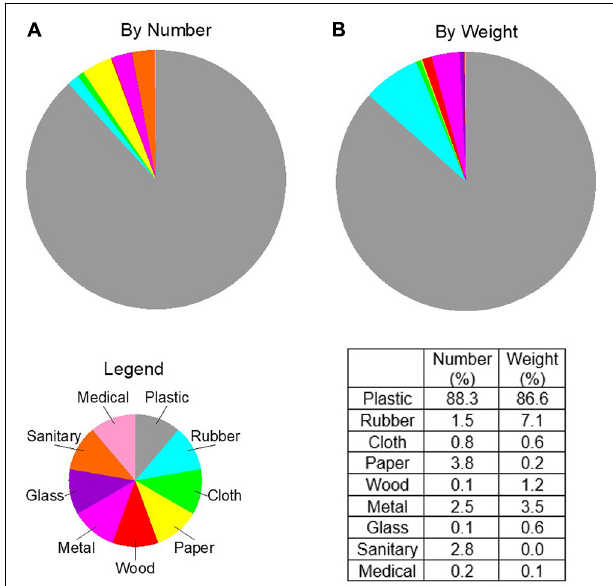
FIGURE 2 | Composition of all beach litter, collected during 4 quarterly surveys of 10 sites in the northeast of Scotland (see Figure 1 ). (A) Percentages of litter types by number of litter items. (B) Percentages of litter types by weight. Legend indicates litter type color coding. Table insert presents actual